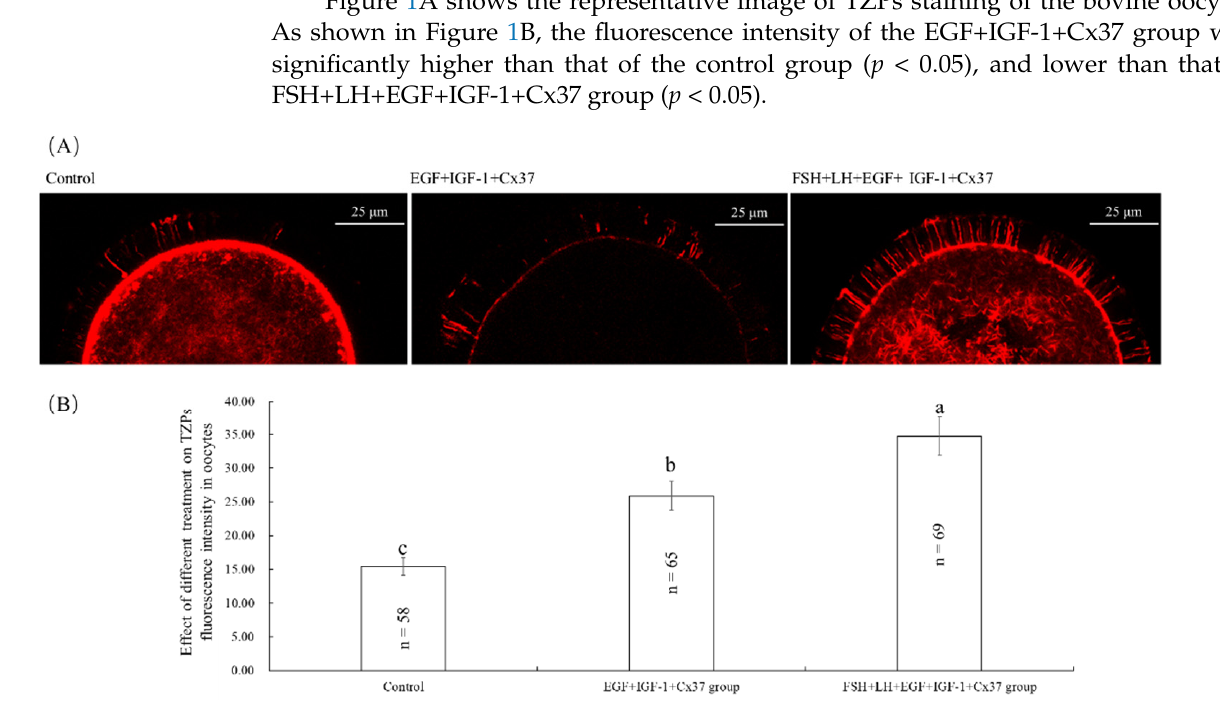
Figure 1. Effect of the combination treatment of EGF, IGF-1, and Cx37 on TZPs in bovine oocytes. ( A ) Representative image staining of TZPs in bovine oocytes. ( B ) Effect of the combination treatment of EGF, IGF-1, and Cx37on TZPs in bovine oocytes. a, b, c Values with different superscripts indicate significant differences between groups ( p < 0.05).